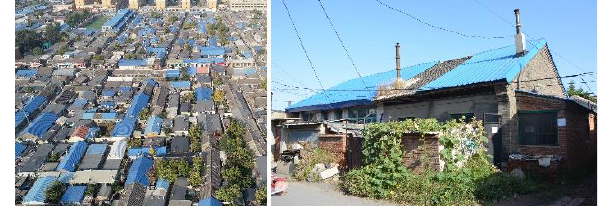
Figure 8. Traditional roofs covered by blue steel plates in the old town of Gaizhou. Source: Xing Zhenpeng and Li Bing,